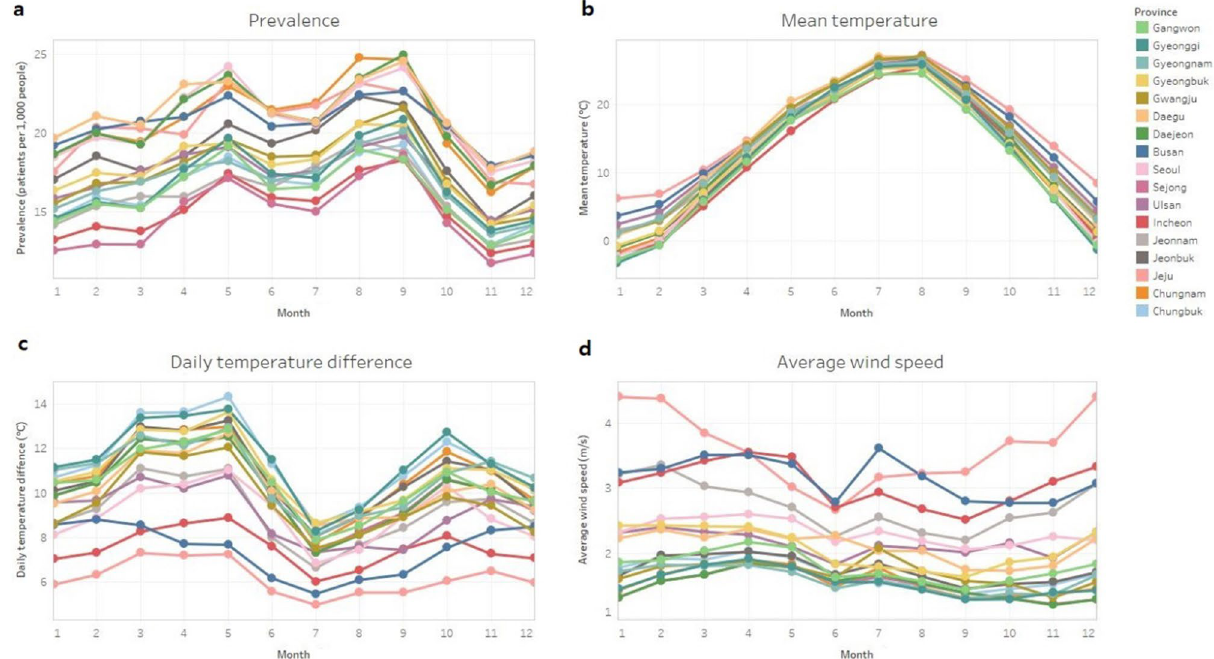
Figure 2. Prevalence of conjunctivitis and weather parameters by month in each region. ( a ) Prevalence of conjunctivitis, ( b ) mean temperature, ( c ) mean daily temperature difference, and ( d ) mean wind